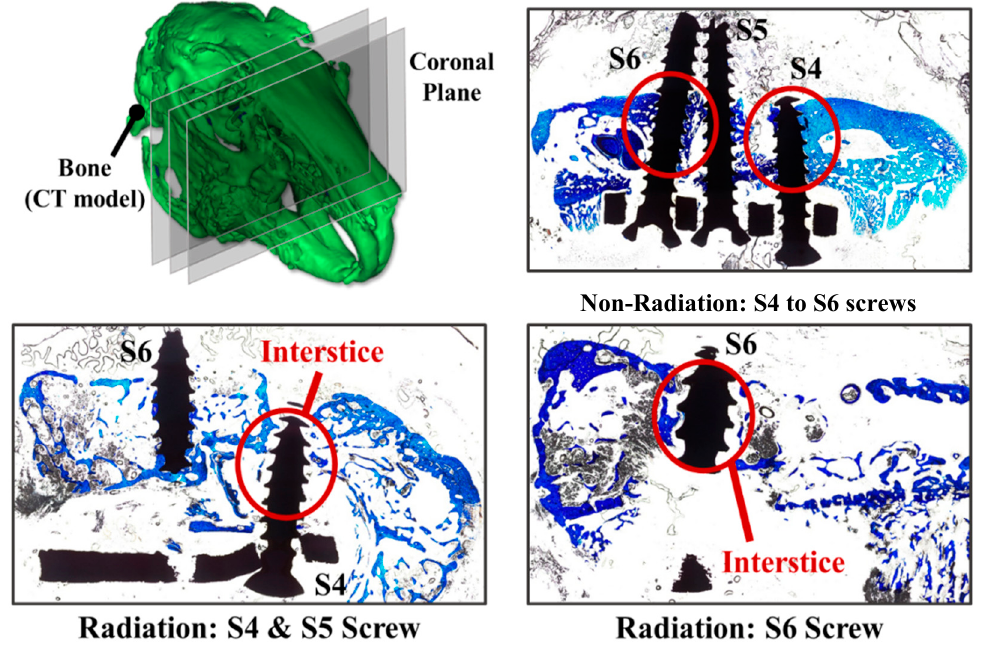
Figure 8. The hard tissue section strain results. Red circle: bone remodeling region around the screws.